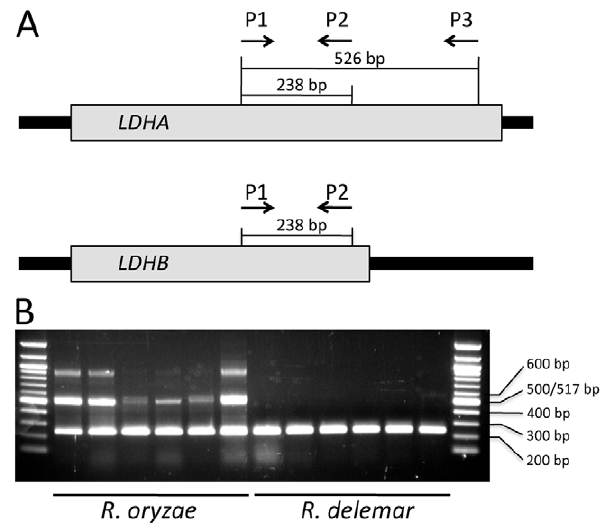
Figure 6. Different copy numbers of lactate dehydrogenase (LDH) in Rhizopusoryzaes.s. and Rhizopusdelemar . (A) LHDA has a longer the 3 9 end compared to LDHB . Primers P1 and P2 recognize both LDHA and LDHB producing 238 bp DNA fragments in PCR, whereas P3 only recognizes the 3 9 end of the LDHA producing 525 bp DNA fragments in PCR with P1. Gene sizes are not to scale. (B) Rhizopus oryzae s. s. strains produces 238 bp and 525 bp bands in a PCR reaction with the three primers P1, P2, and P3, however, R. delemar strains produce only 238 bp bands with the same PCR conditions. Non-specific amplification of 900 bp bands occurred with several R. oryzae s. s. strains. Size marker is 100 bp ladder (NEB, Ipswich, MA, USA). Rhizopus oryzae s. s. strains are (from left to right) NRRL2908, CBS346.36, NRRLA- 336, CBS110.17, NRRL1897, NRRL1501 and Rhizopus delemar strains are (from left to right) ATCC34612, NRRL2871, NRRL2005, NRRL1528, NRRL21447, NRRL13908.